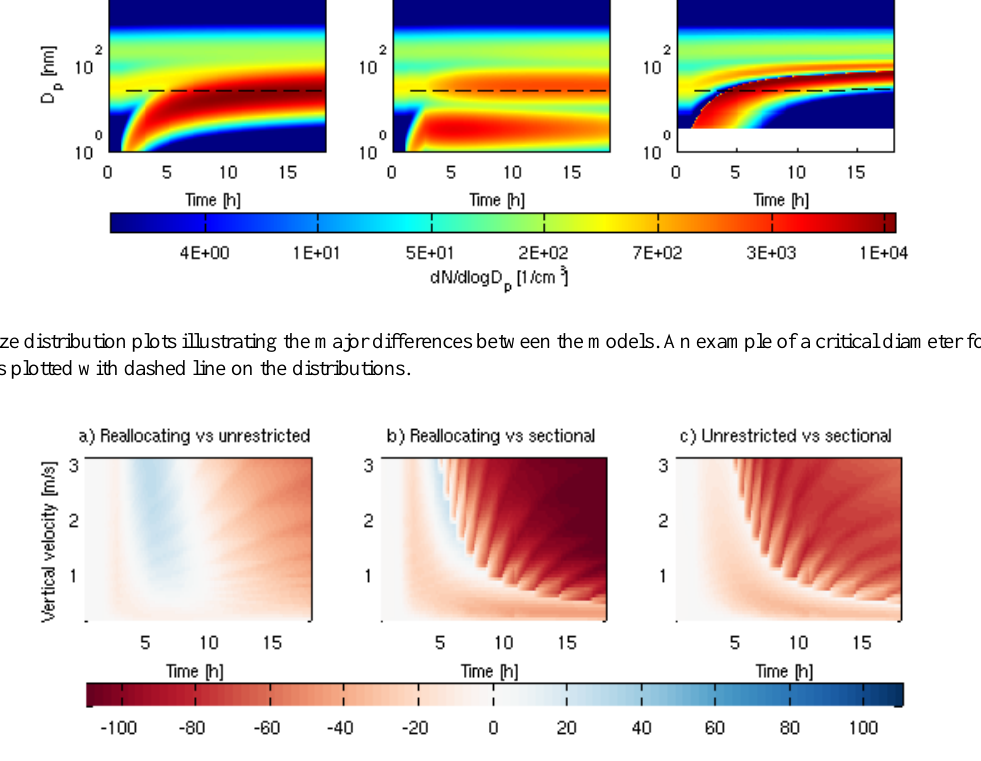
Fig. 10. Relative difference of the CDNC between the three models. Notice the small area of overestimation by the reallocating model compared to the unrestricted model (a).